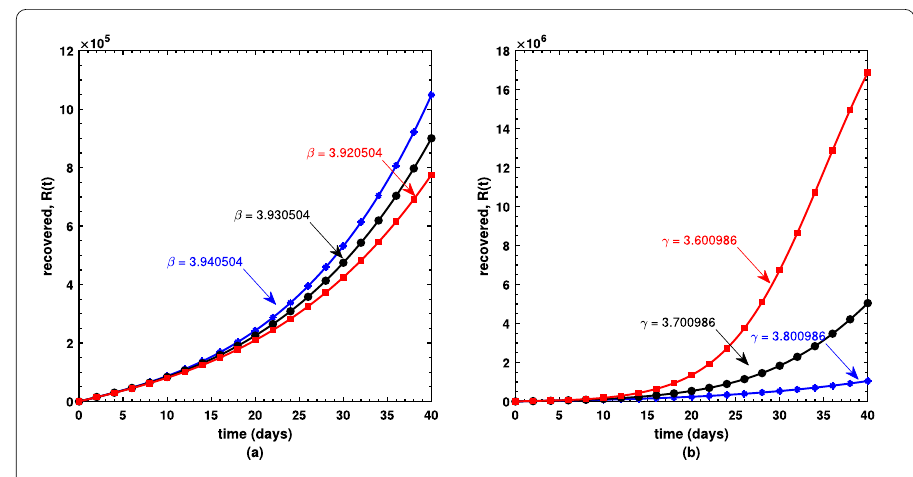
Figure 7 Behavior of the recovered population under varying values of β and γ